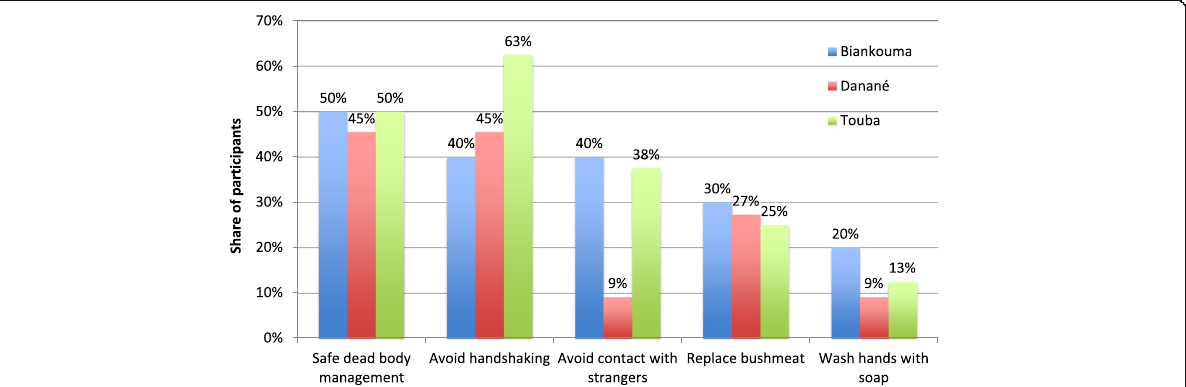
Fig. 4 Most difficult unsafe practices across districts to adopt, according to participatory workshops participants. Percentages represent the share of participants rating the attribute in the top range, on a scale from 1 to 5, in terms of how important it is to